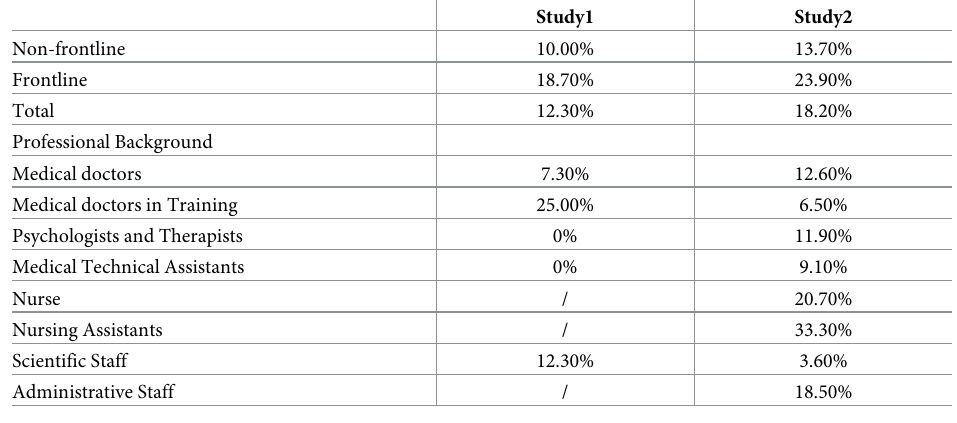
Table 3. Prevalence of poor sleep quality; PSQI Cutoff >